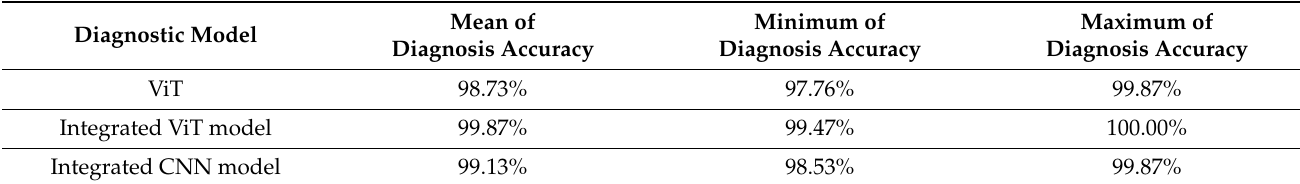
Table 3. Performance comparison of individual ViT, integrated ViT and integrated CNN.